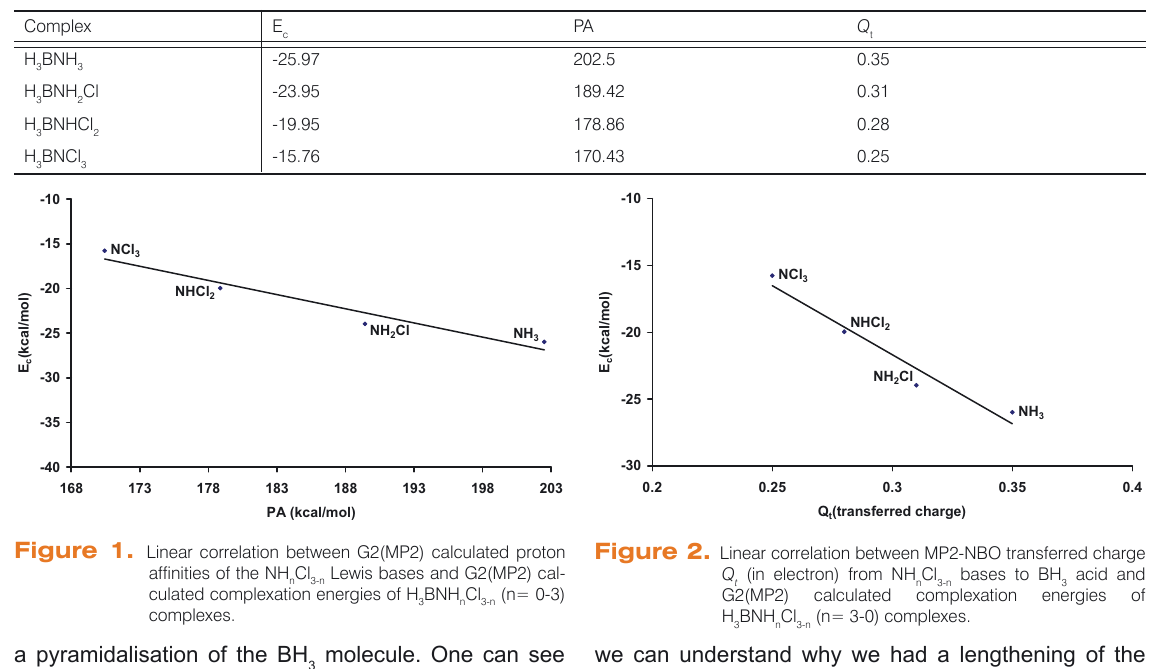
Q (in electron) from NH t G2(MP2) calculated complexation energies